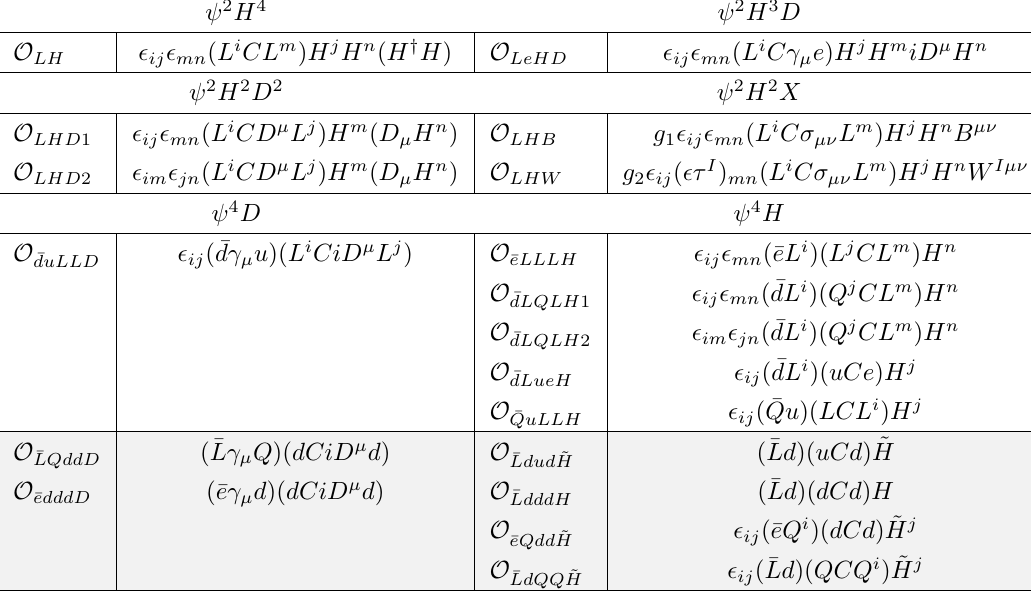
Table 1 . Dim-7 operators in 6 classes are divided into two subsets with L = 2 and B = 0 and B = (cid:0) L = 1 (in gray) respectively, where ( D (cid:22) H n ) should be understood as ( D (cid:22) H ) n